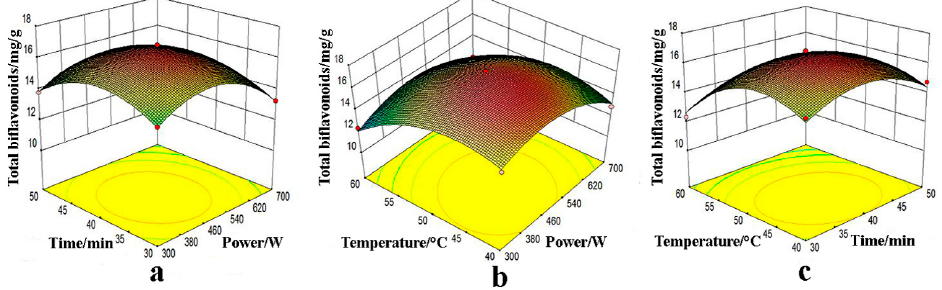
Figure 4. Interaction effects of microwave power and extraction time ( a ); microwave power and extraction temperature ( b ); extraction temperature and time ( c ) on total biflavone yields.